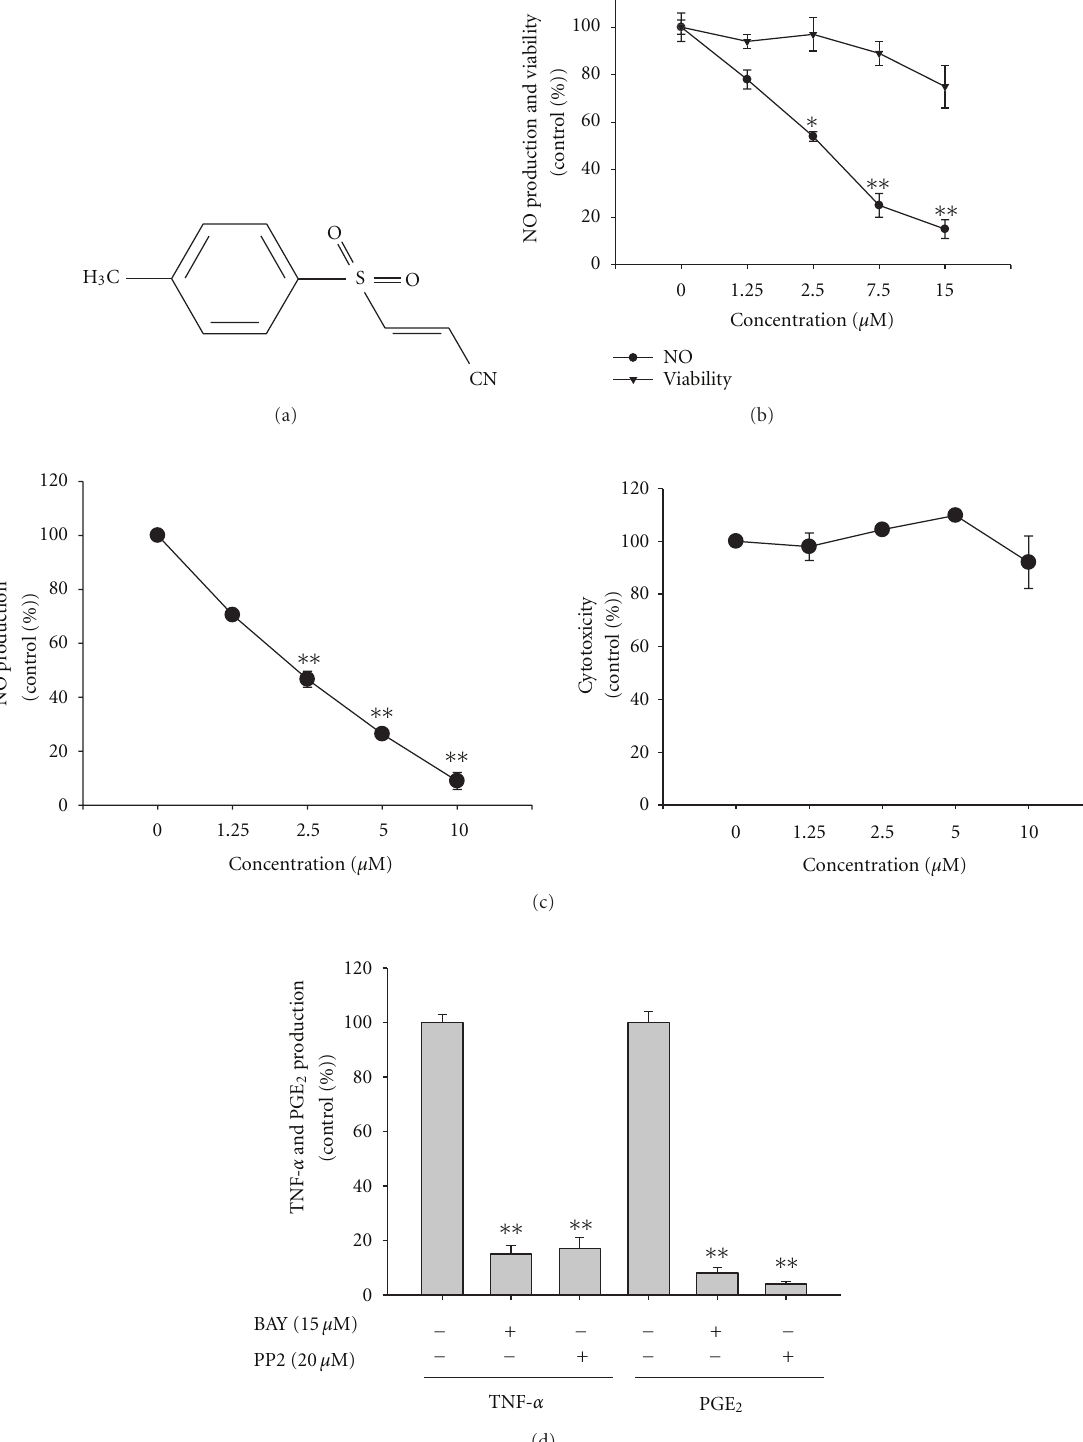
Figure 1: E ff ect of BAY (BAY 11-7082) on the production of NO, TNF- α , and PGE 2 in RAW264.7 and peritoneal macrophages, and cell viability. (a) Chemical structure of BAY. (b, c left panel, and d) Levels of NO determined by the Griess assay, TNF- α by ELISA, and PGE2 by EIA from culture supernatants of RAW264.7 cell (b and d) and peritoneal macrophages (c) treated with BAY (0 to 15 μ M) in the presence or absence of LPS (1 μ g/mL) for 6h (TNF- α ) or 24 h (NO and PGE 2 ). (b and c right panel) Viability of RAW264.7 cells treated with BAY by MTT assays. ∗ P < 0 . 05 and ∗∗ P < 0 . 01 compared to the